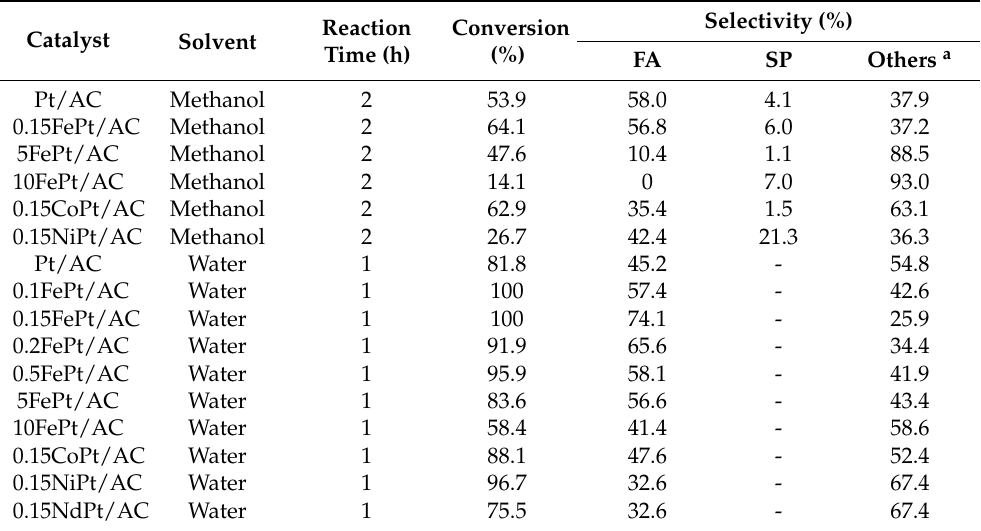
Table 2. Catalytic reaction of the selective hydrogenation of furfural to furfuryl alcohol over the prepared